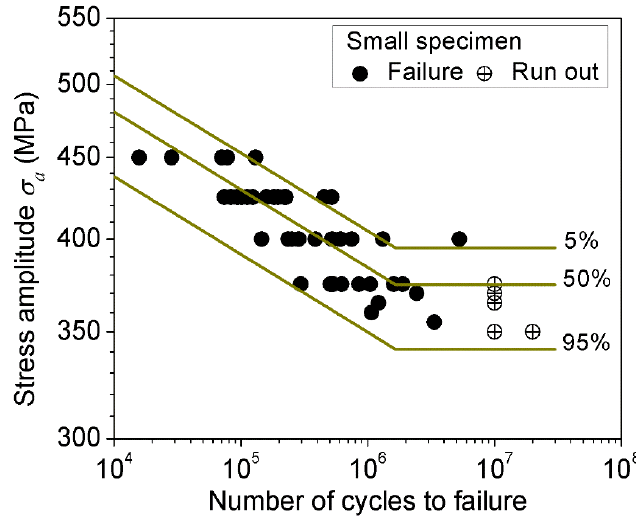
Figure 10. Comparison of predicted P-S-N curves with experimental data for the small specimen in literature [24].